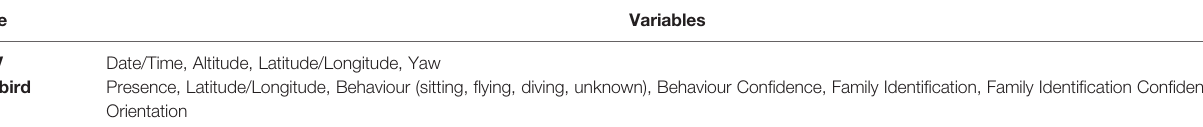
TABLE 2 | UAV and seabird variables stored within GUI output fi le.